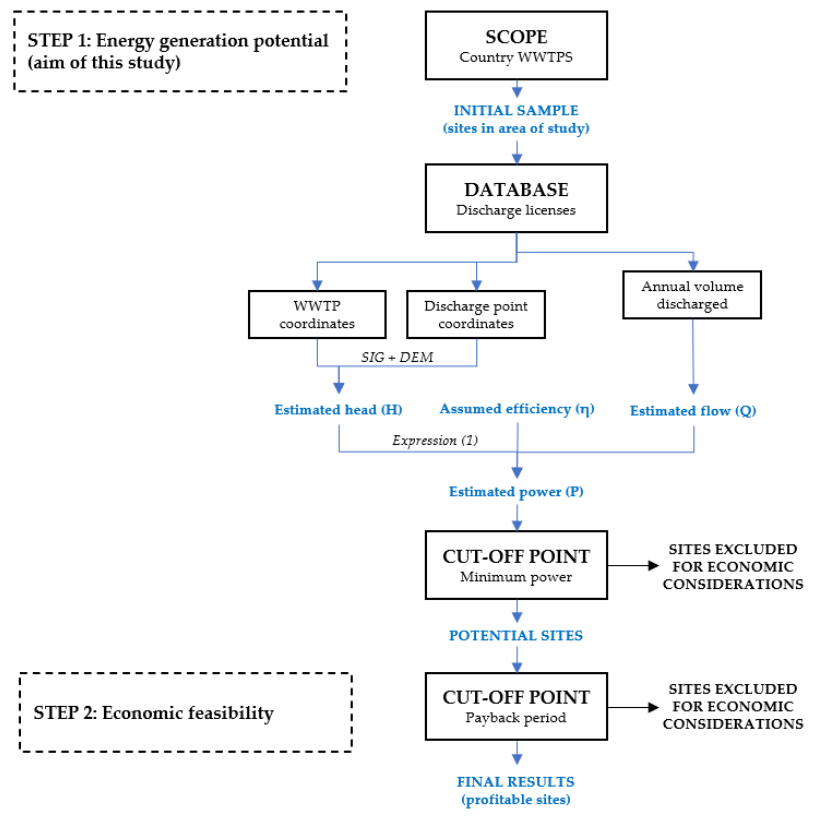
Figure 2. General approach in existing methodologies.